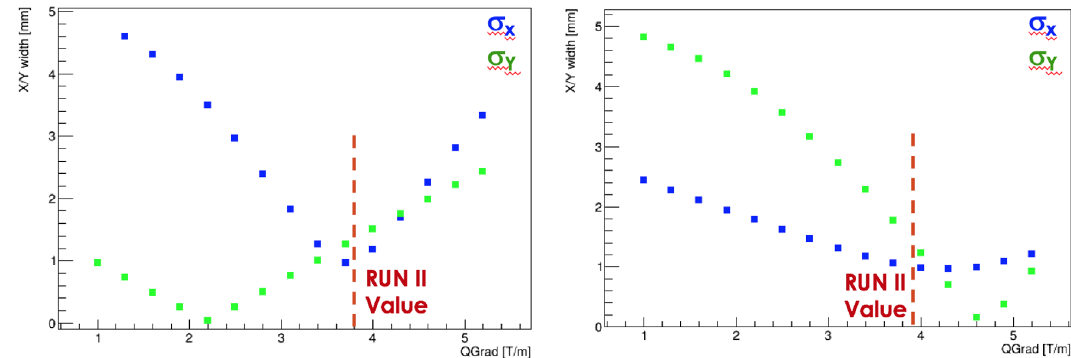
Figure 10 . Beam transverse width on target vs. quadrupole Q3 (left) and Q4 (right). The vertical red-dashed line represents the actual gradient used during Run